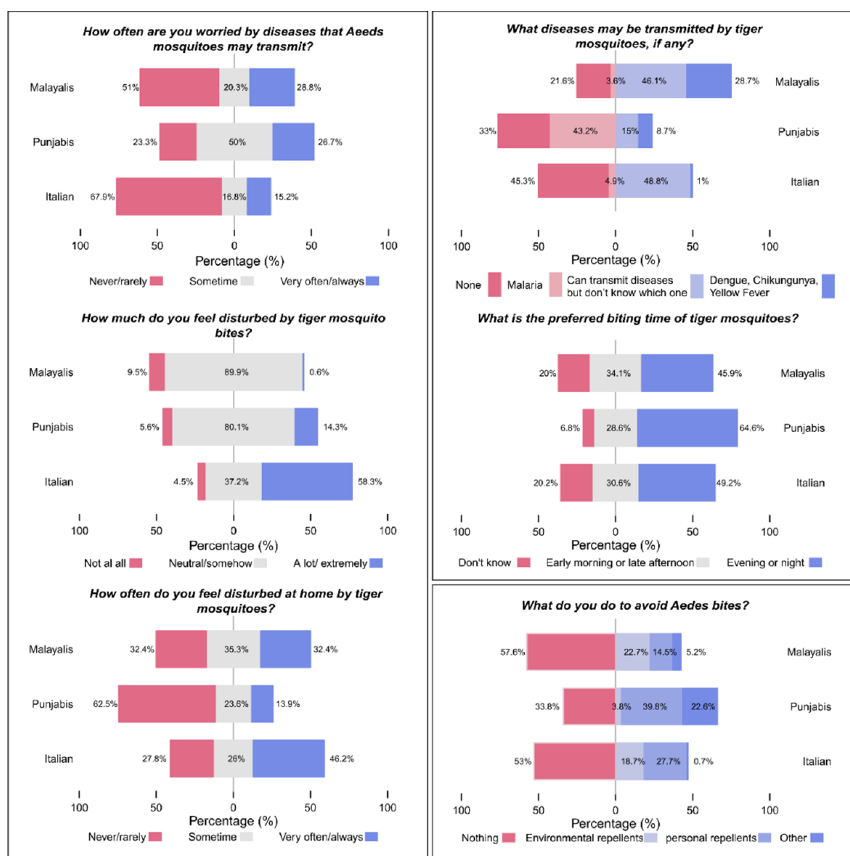
Figure 2. Frequency of answers to knowledge (2 out 3 questions, upper right), attitude (3 questions, left box) and practice questions (one question, low right) for the three groups (Malayalis N = 204, Punjabi N = 266, Italian N = 1109). Table 2. Multivariate odds ratios (ORs) (95% confidence interval) of KAP compared to the Italian group. Model adjusted for age, sex and education